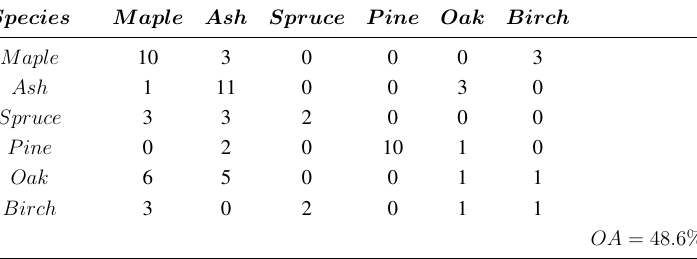
Table 2. The C5.0 decision classification results with 4-band spectral information